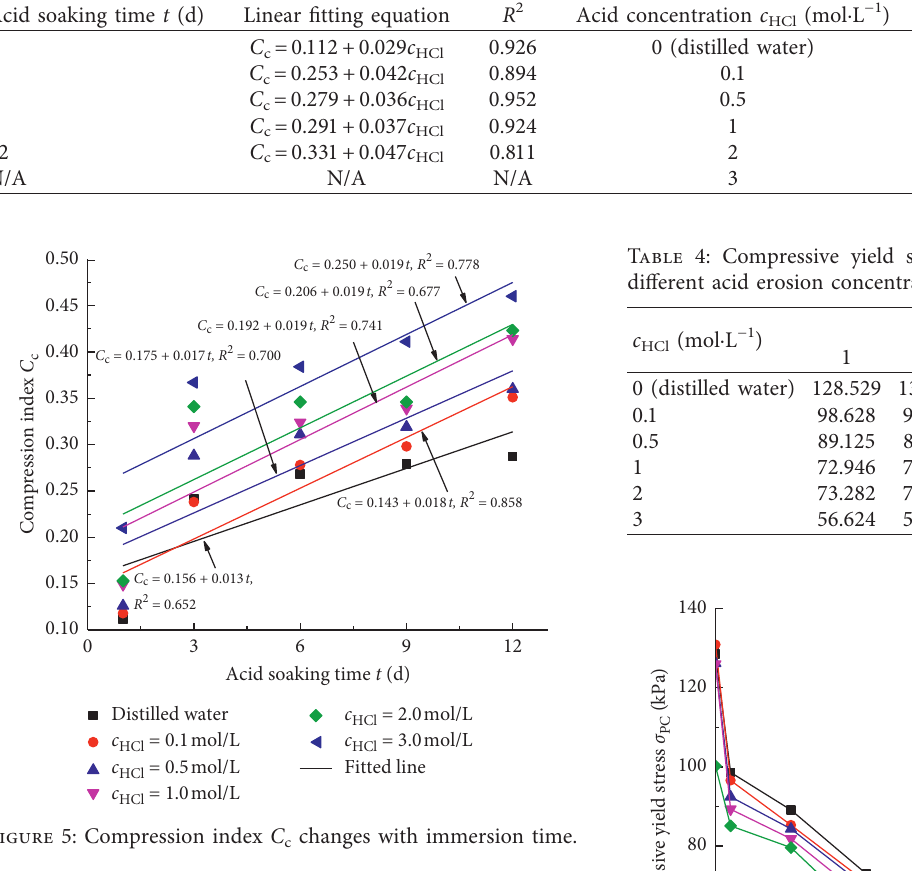
c changes with immersion time.